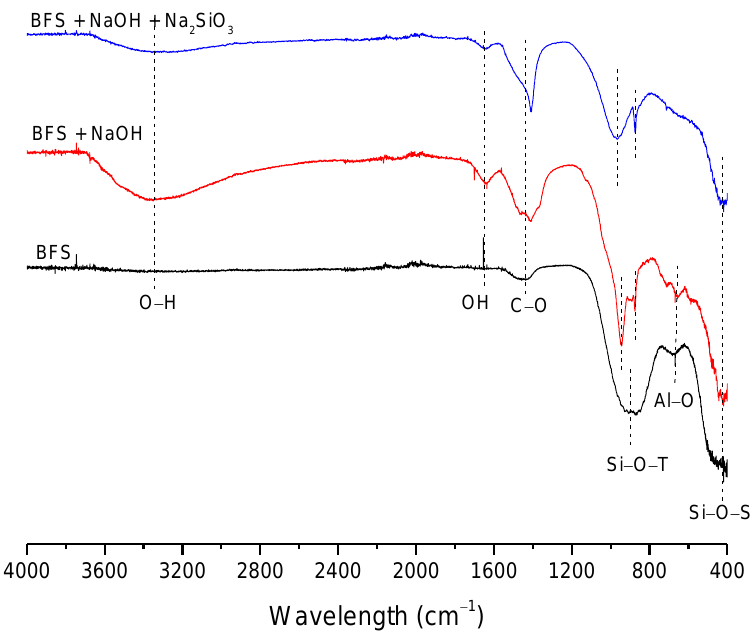
Figure 8. BFS and BFS activated pastes.